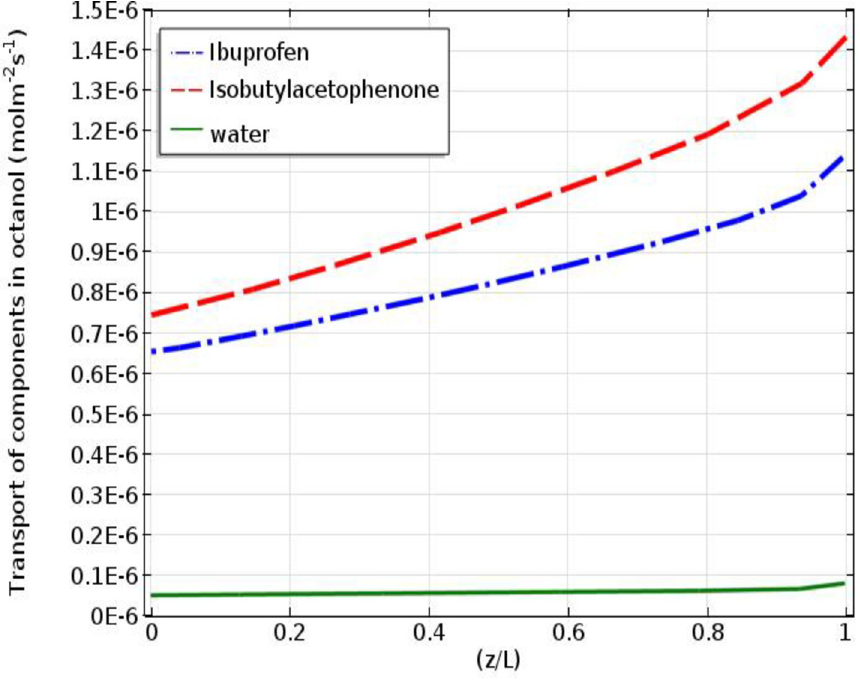
Fig 6. The amount of components’ transport in the octanol organic solution at the shell-membrane